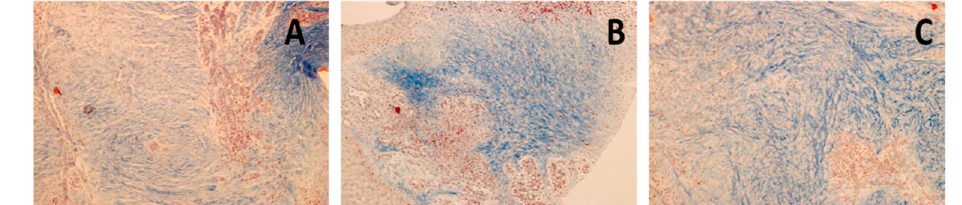
Figure 4. ( A – C ) Masson’s trichrome stain of tissue biopsies from Patient 2. Masson’s stain indicating collagen formation and myofibroblastic proliferation after WMCS treatment.